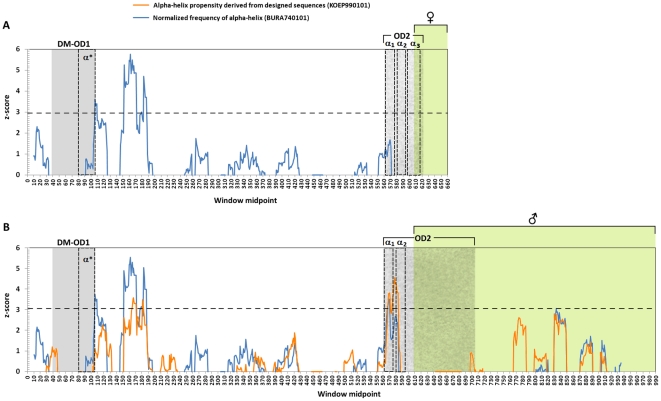
Sliding window plots of the z-scores of radically changed properties showing regions under positive-destabilizing selection in (A) female and (B) male isoform.DM/OD1 – DNA-binding and dimerization domain. OD2 – dimerization domain 2. α1, α2 and α3 – alpha-helices that compose the predicted UBA-like domain. α* - disordered C-terminal tail, proposed to fold as an alpha-helix. Dashed horizontal line indicates the Bonferroni corrected significant limit (z-score = 3.07, p<0.05, male exon; z-score = 2.95, p<0.05, female exon).